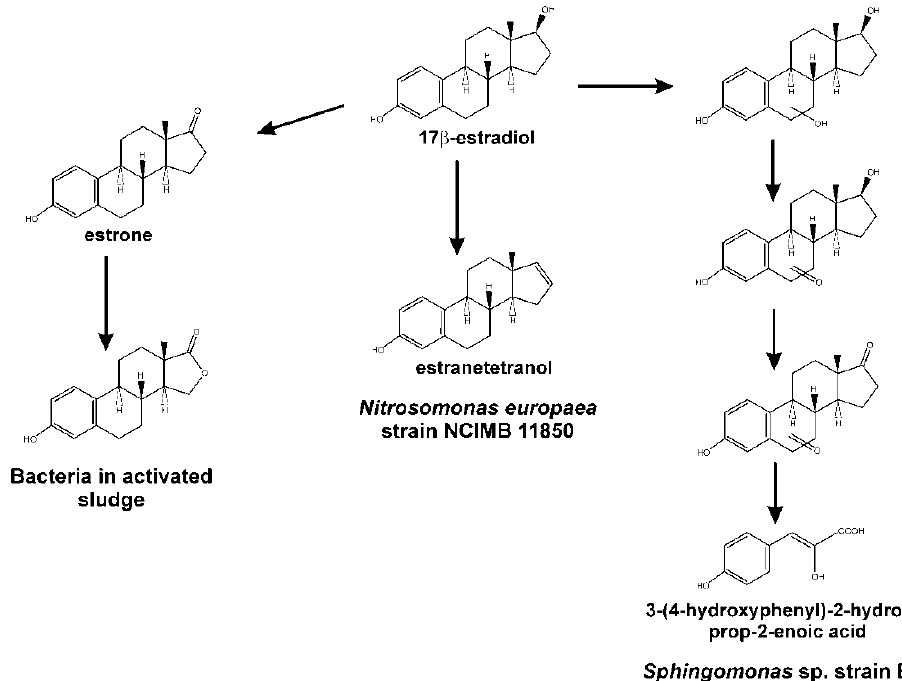
Figure 9. Metabolic alternatives to the 4,5- seco pathway proposed for estrogen mineralisation/biotransformation in different bacterial species.